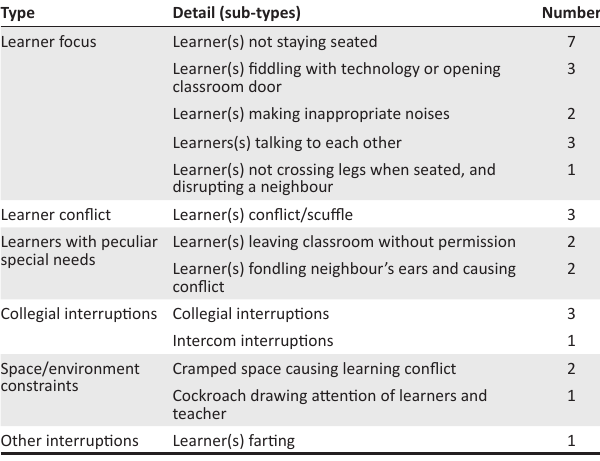
TABLE 1: Number and types of classroom management